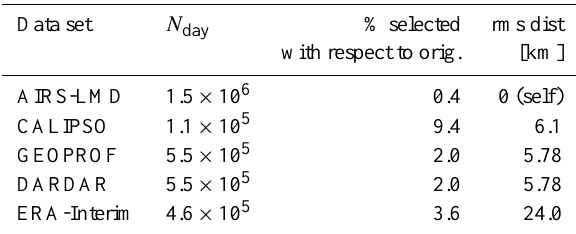
Table 2. Colocation statistics corresponding to the data illustrated in Fig.